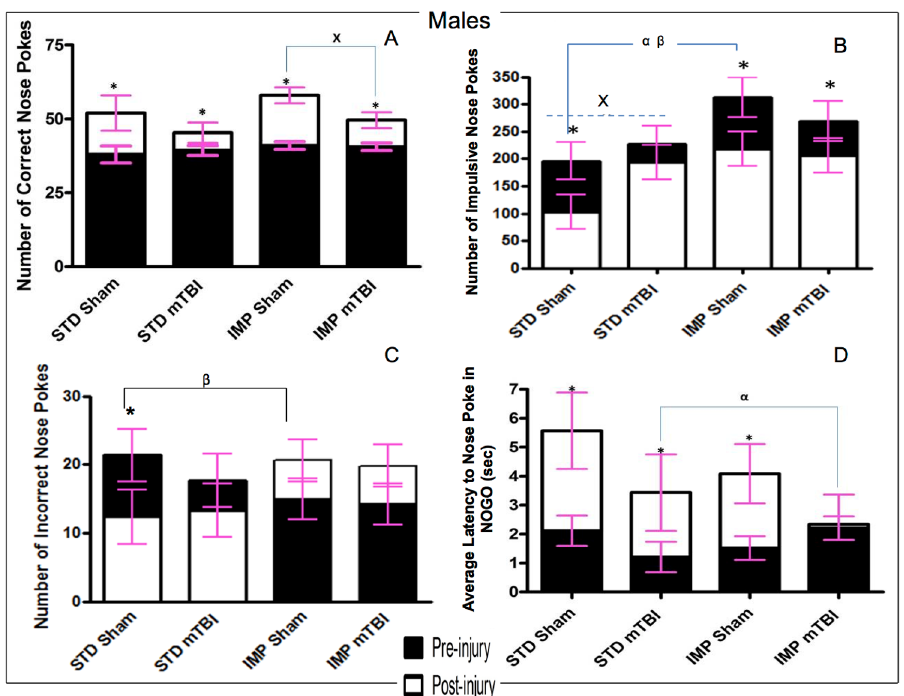
Fig 6. Graphical representation of Go/No-Go results. A) accuracy, B) Impulsivity, C) Inaccuracy, and D) Response Inhibition, for male animals from the STD and IMP cohorts at the pre-injury (black bars) and post- injury (white bars) test sessions. Overall accuracy increased across all cohorts from the pre-injury session to the post-injury session, but the magnitude of change was greater for sham animals. Males in the STD cohort exhibited a reduction in incorrect nose pokes with increased training but animals in the IMP cohort actually exhibited an increase in incorrect nose pokes. Cohort and mTBI increased impulsivity when compared to STD-sham animals. Finally, all males except IMP-mTBIs demonstrated improvements in latency to nose poke on the NOGO trials, but again the magnitude was greatest for STD-shams ( α significant effect of IMP at pre-injury, β significant effect of IMP at post-injury, x significant effect of mTBI, * significant effect of testing period, all p <